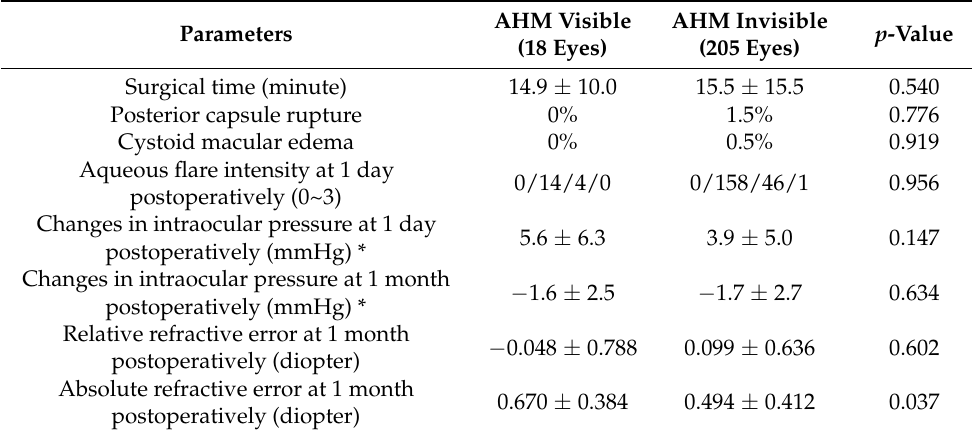
Table 3. Intraoperative and postoperative parameters.